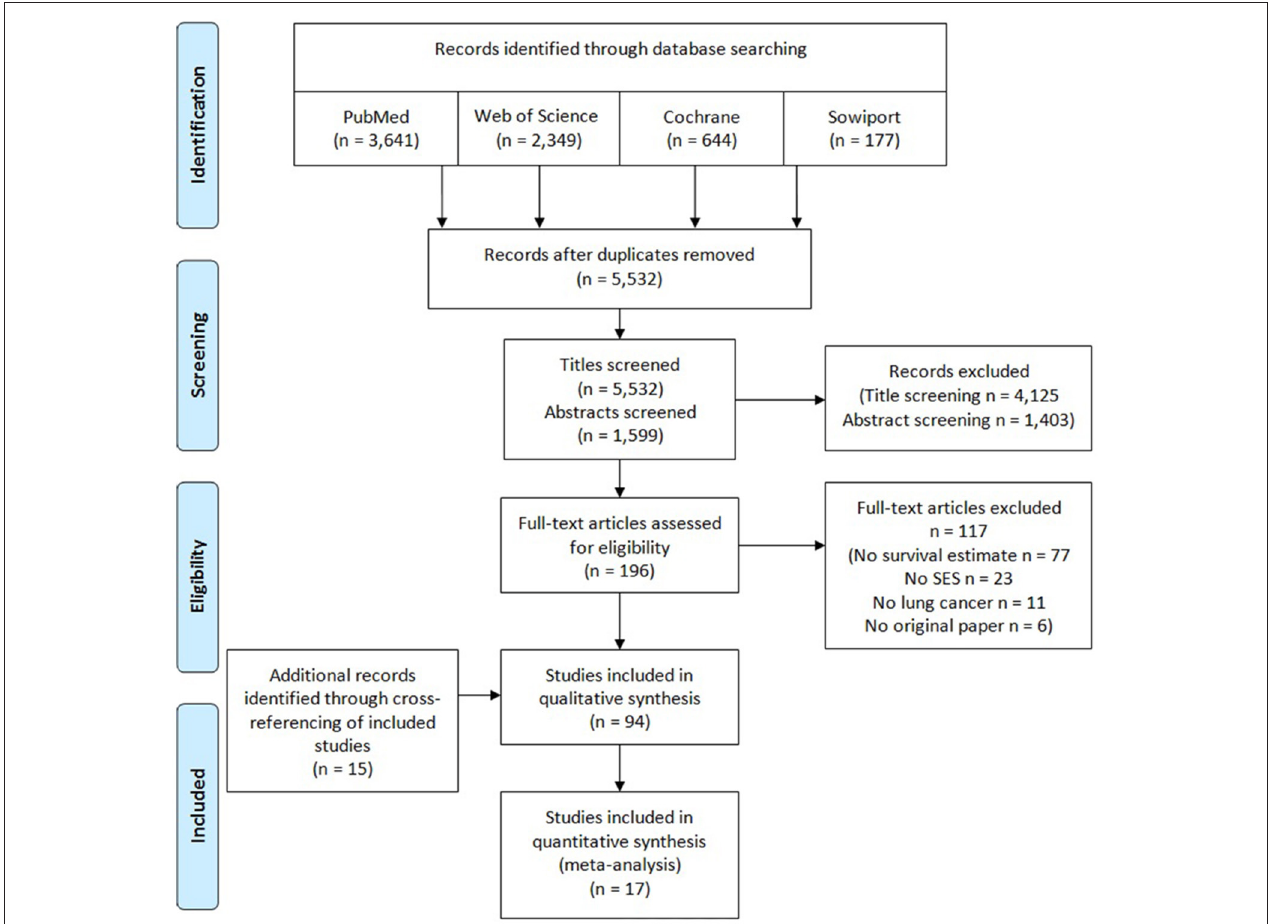
FIGURE 1 | PRISMA flow diagram of study selection process for a systematic review and meta-analysis on socioeconomic differences and lung cancer survival.